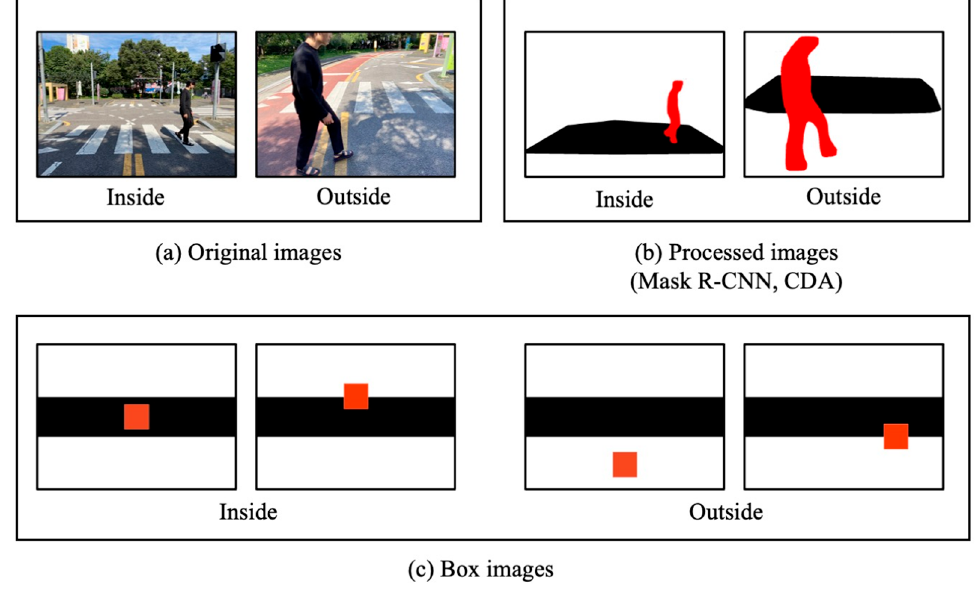
Figure 5. Three types of datasets of the experiments; ( a ) Original Images and ( b ) Processed Images applied for Experiment I, and ( c ) Box Images applied for Experiment II.